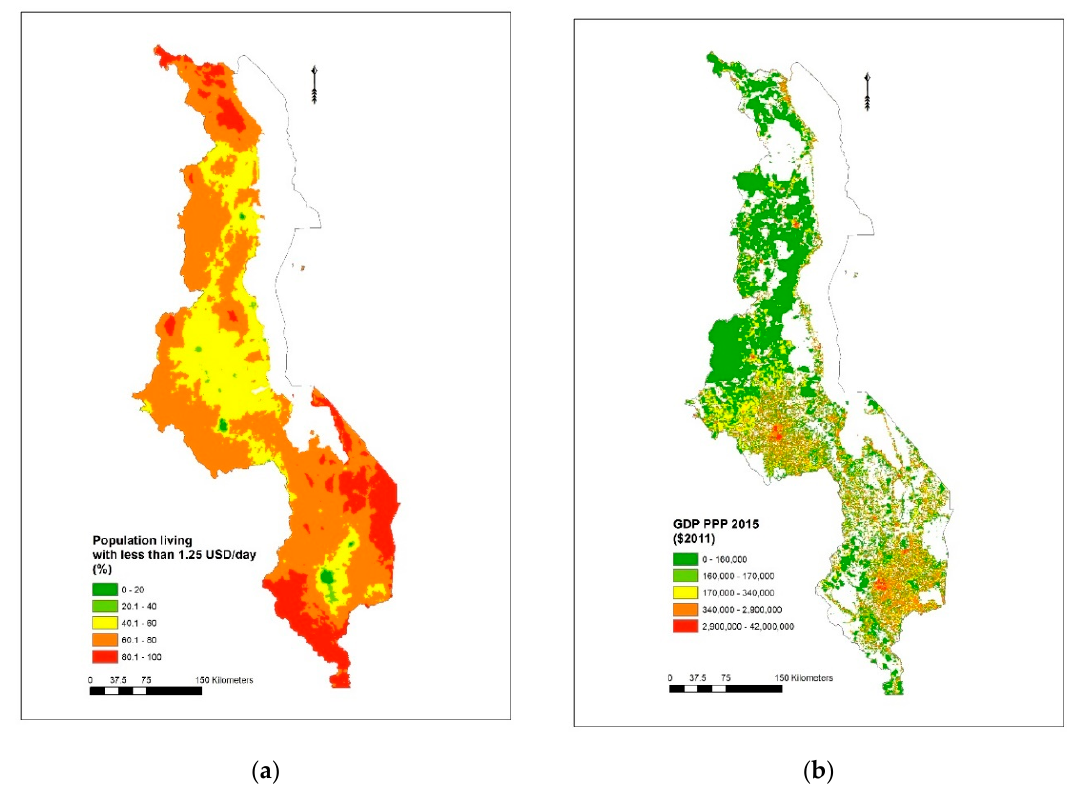
Figure 3. Poverty rates ( a ) and estimated purchasing power parity Gross Domestic Product (GDP-PPP) in 2011 USD values ( b ) as distributed over population clusters in Malawi.